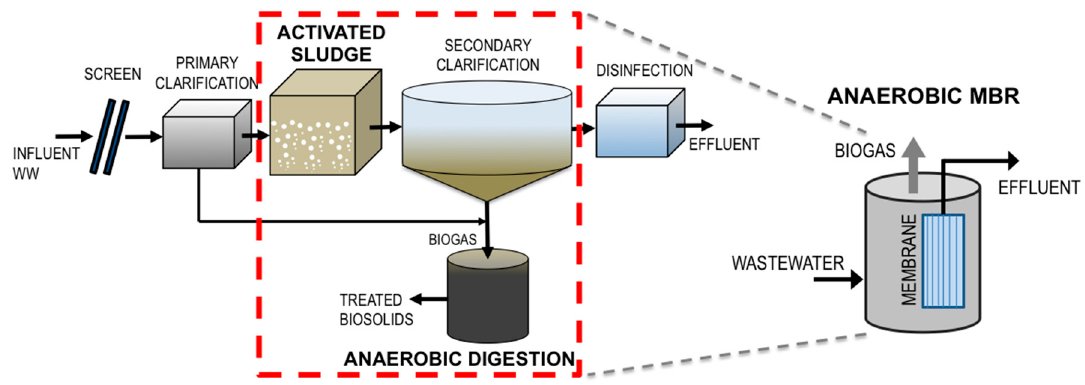
Figure 1. Schematic diagram of anaerobic MBR (AnMBR) potential to reduce central wastewater treatment plant processes and footprint. AnMBR can be used to replace activated sludge, secondary clarification and anaerobic digestion (i.e., processes enclosed within the red dashed line), hence reducing the footprint of a wastewater treatment plant.